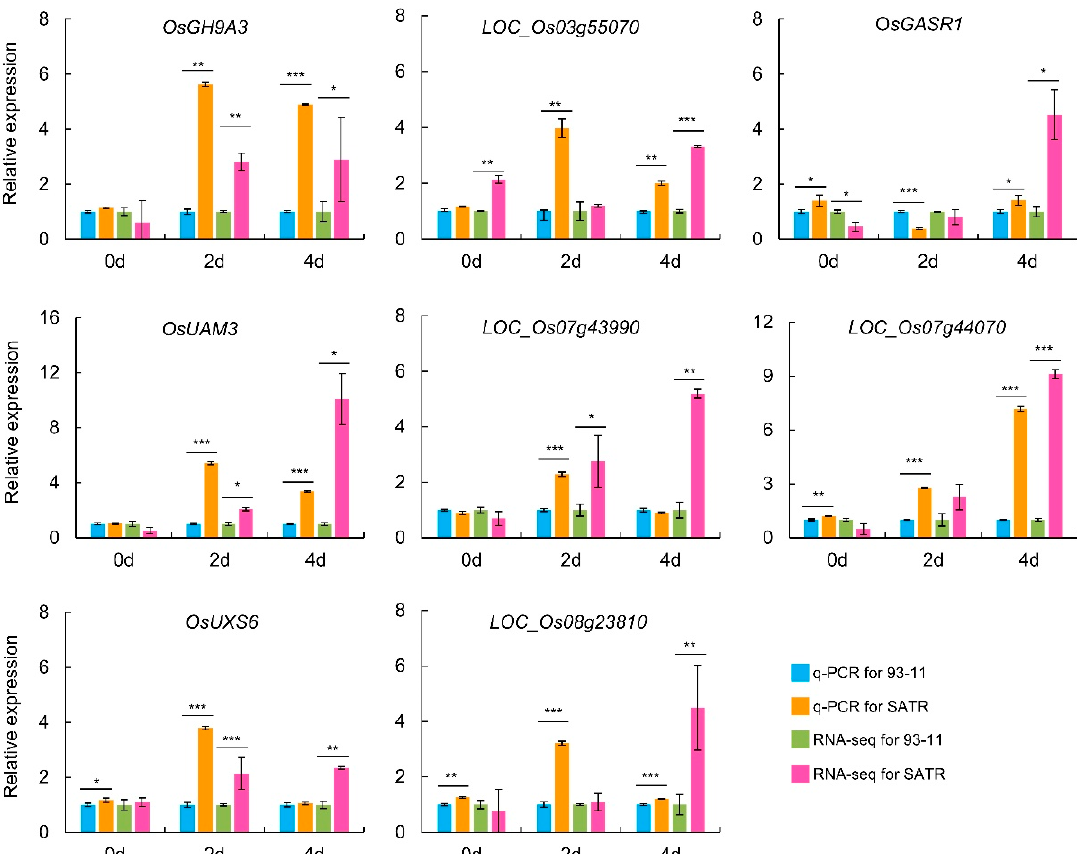
Figure 5. Comparison analysis of gene expression levels and patterns of the selected genes between SATR and 93-11 by qRT-PCR and RNA-seq results. The value of OsActin mRNA was used as the reference control for data normalization. The expression levels of the eight genes in 93-11 were scaled to 1 for qRT-PCR analysis under SSAS for 0 days, 2 days, and 4 days, respectively. The FPKM values of the eight genes in 93-11 were scaled to 1 for gene expression analysis of RNA-seq data under SSAS for 0 days, 2 days, and 4 days, respectively. FPKM, fragments per kilobase of transcript per million mapped reads. Data is given as mean ± SD, which was obtained from three independent biological replicates, and each sample contained five mixed seedlings. Student’s t -test, * p < 0.05, ** p < 0.01, *** p < 0.001.